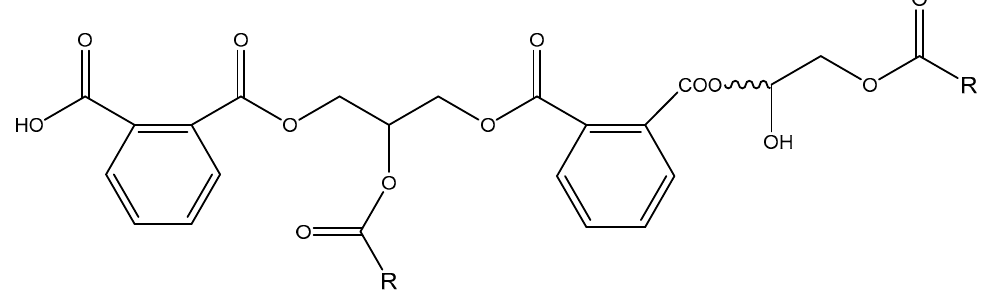
Figure 1. Probable structure of alkyd resin (fatty acid in triglyceride oil is shown by R).